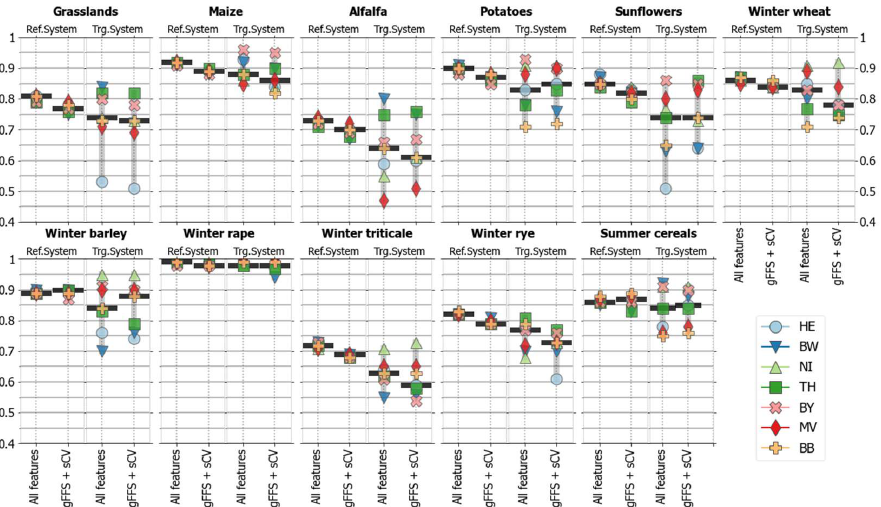
Figure 8. Crop-specific classification accuracies (F1-score) in reference and target systems based on the optical-SAR combination and two feature selection approaches. The abbreviation keys are provided in Table 2. For a complete plot with three sensor groups, check supplementary material